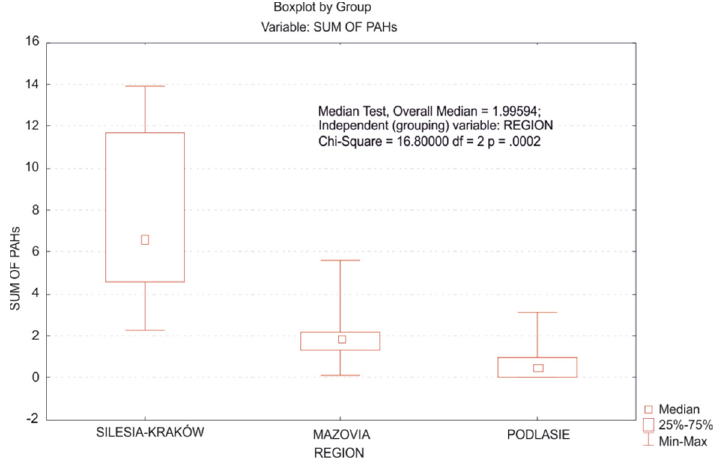
Figure 5. Concentrations (ng kg − 1 d. wt.) of sum of PAHs in Pleurozium schreberi in 2010. Medians (horizontal lines), quartiles (boxes), minimum and maximum values (whiskers) are shown.